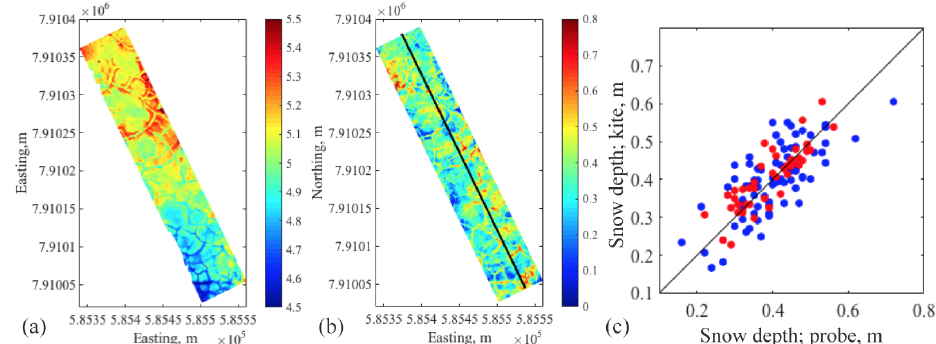
Figure 4. (a) Phodar-derived DSM in meters (August 2014), (b) phodar-derived snow depth in meters (May 2015) and (c) comparison between the phodar-based and probe-based snow depth at all the locations (blue circles) and at selected locations (red circles) having low topographic variability (the sub-meter elevation variability less than 0.05m). The black line in (b) represents the snow depth probe measurements every 3m along the 500m transect.